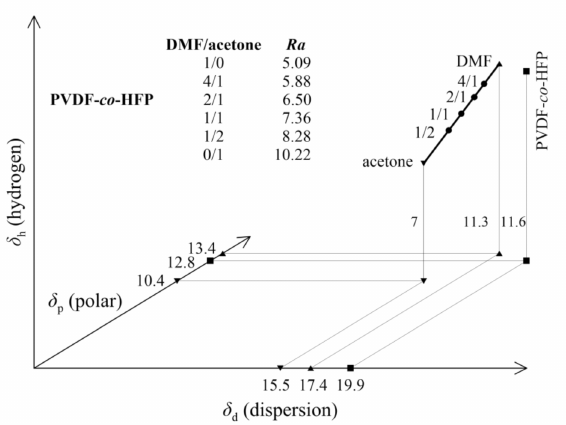
Figure 3. The Hansen space with location of the individual solvents and PVDF- co -HFP. In evaluating the polymeric materials, viscosity was measured as depicted in Figure 4. . γ = 0.12 s − 1 was chosen within the Based on oscillatory measurements, the value of linear viscoelastic region. As expected, for fixed copolymer concentration c co [wt.%], the viscosity decreases with increasing participation of acetone c ac [wt.%] in the solvent mixture. However, for higher values of c co we can see that no data are at disposal, due to the fact that in this case mixture behaviour rapidly deteriorates and viscosity cannot be determined, as well as no nanofibers being able to be electrospun (which is also confirmed in the literature [30]).